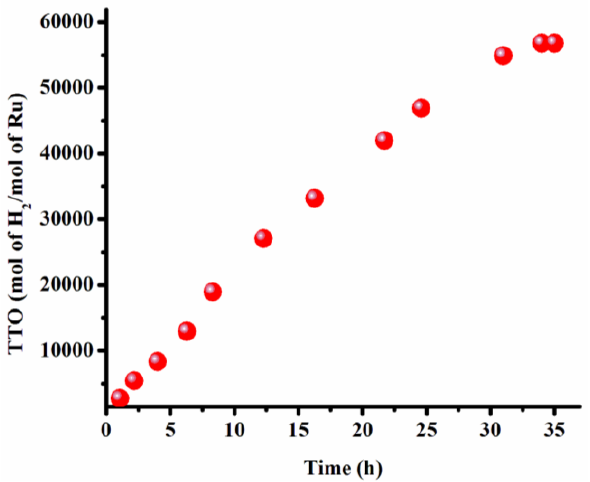
Figure 6. Total turnover number (TTO) versus time for the catalytic lifetime of ruthenium(0) NPs (0.50 mM) in the hydrolysis of ammonia-borane at 25.0 ± 0.1